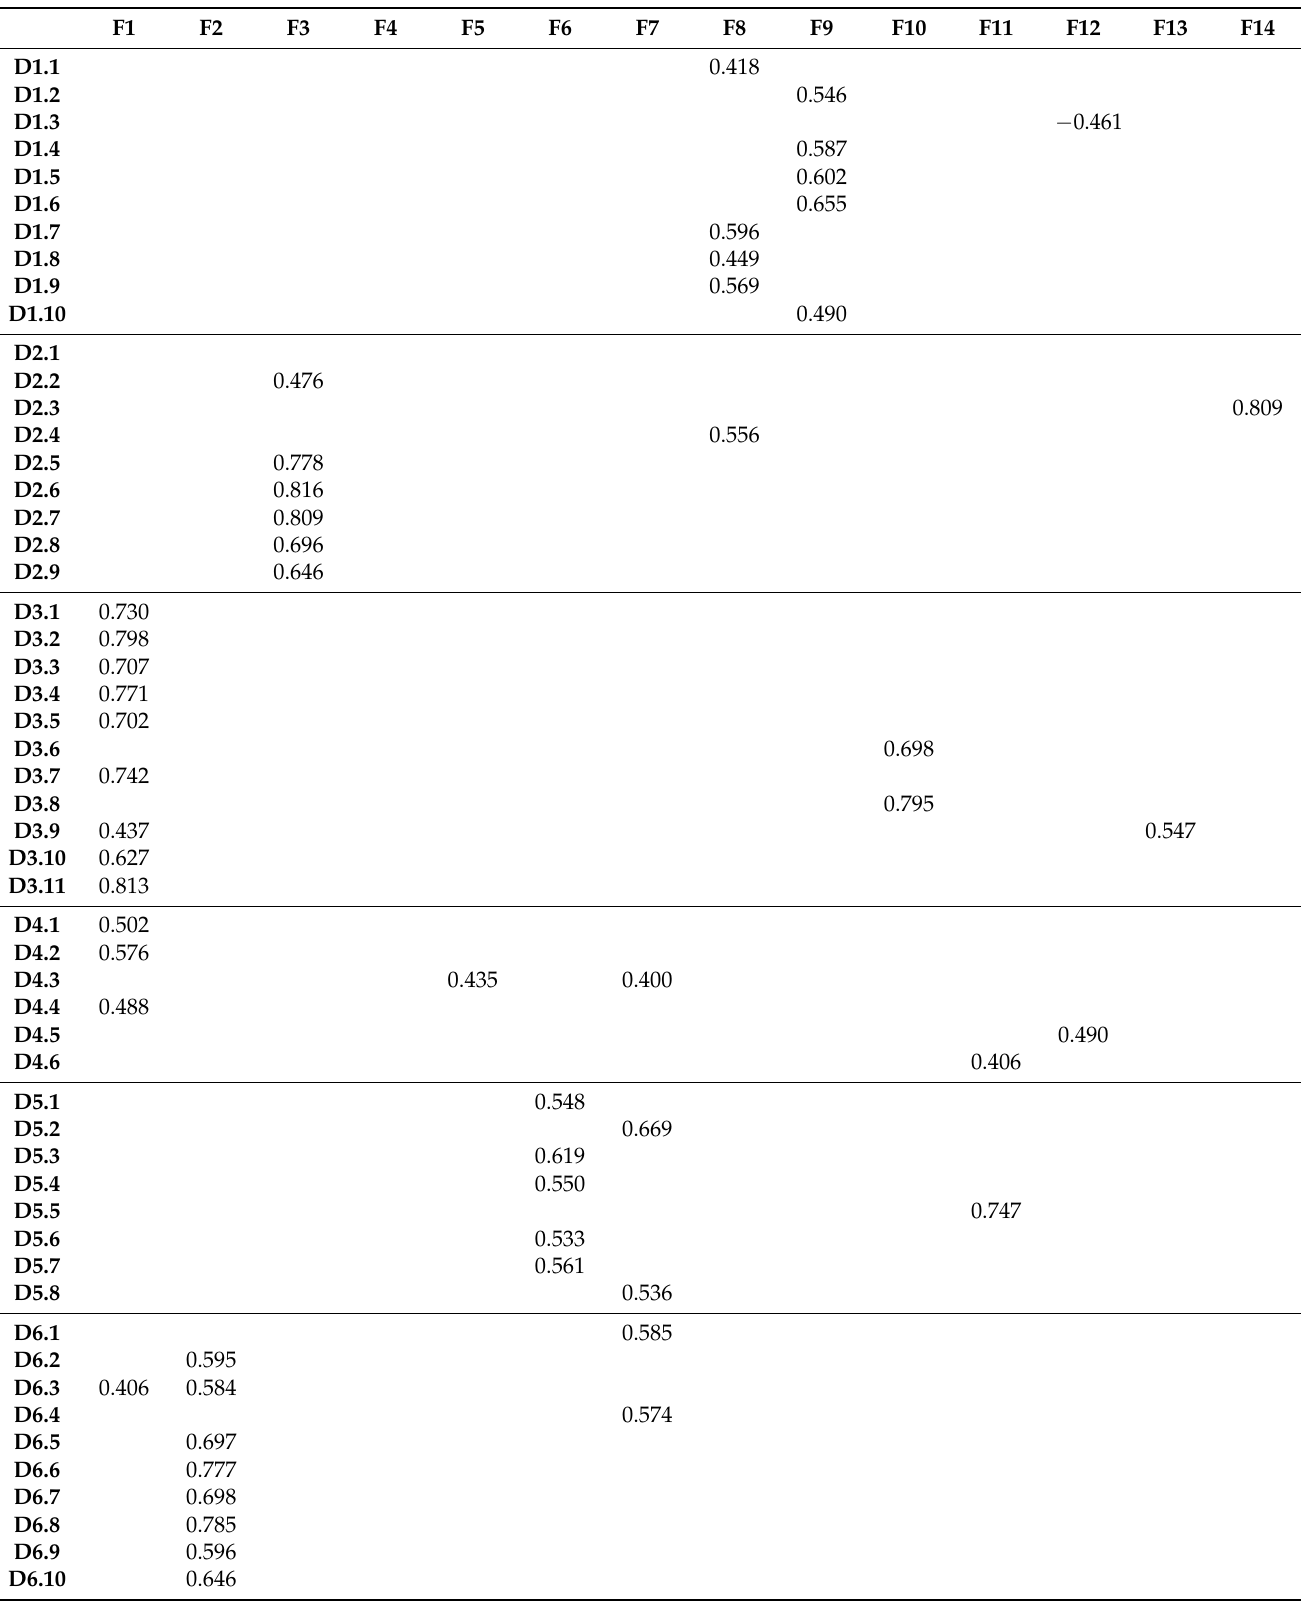
Table A2. Results (loadings) of the FA solution with extraction by PCA with varimax rotation (loadings lower than 0.4 were